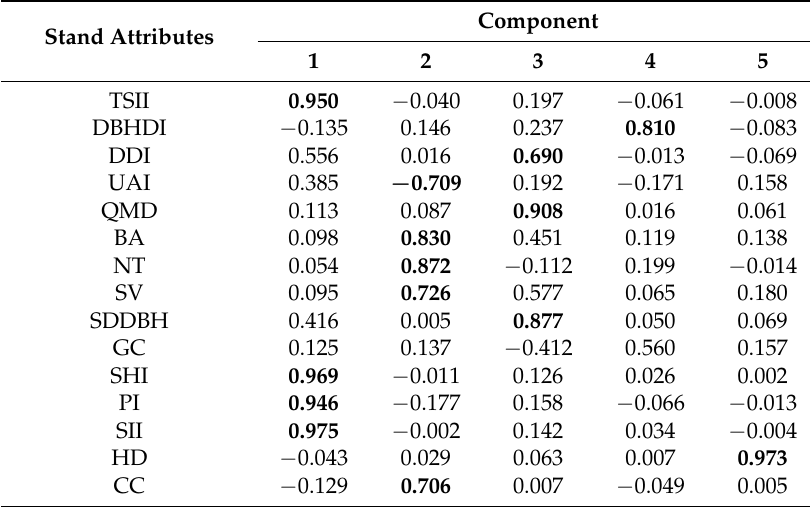
Table 4. Rotated component matrix generated by factor analysis. Stand